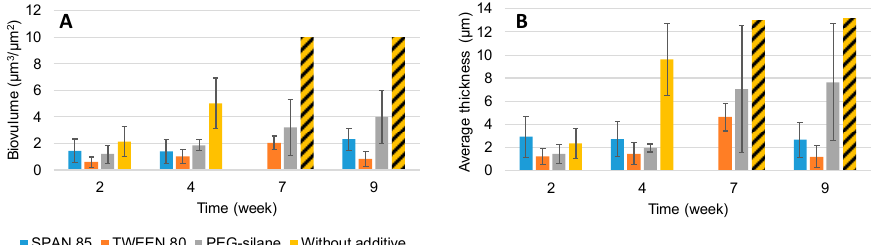
Figure 6. Evolution of A. Biomass and B. Average thickness developed onto paints during immersion. The bare are the mean of five measurements. saturation of biofilm.